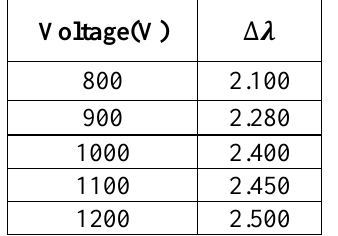
Fig. 4: The full width at half maximum ( ) by Gaussian fitting to argon atom (Ar1) for wave length (750.38) nm. Table 3: The full at half maximum ( ) increase with increase voltage from 800 to 1200 V.